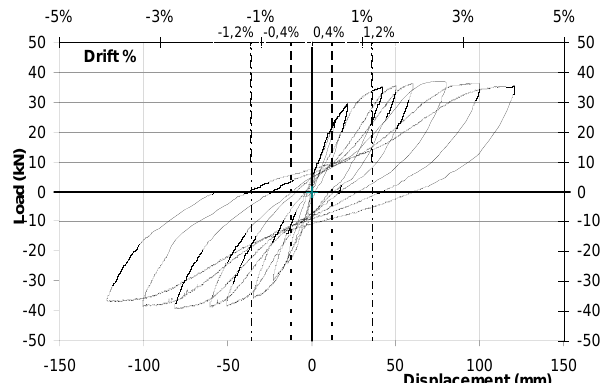
Figure 5 Load-top displacement hysteresis curve of reference bare frame RFB1 Fig. 5. Load-top displacement hysteresis curve of reference bare frame RFB1.